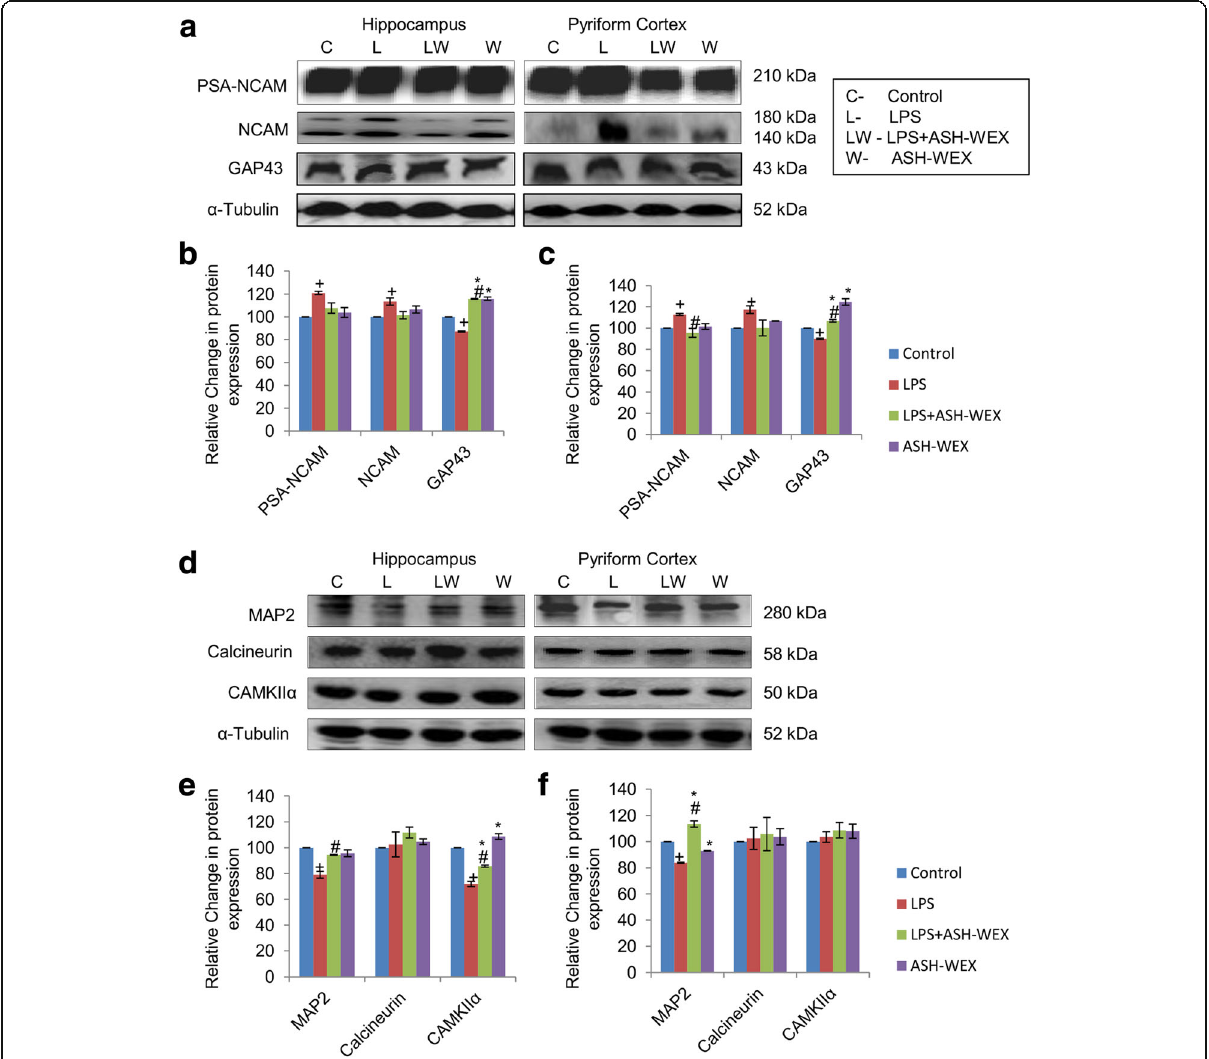
histograms depicting relative densitometric analysis amidst the different treatment groups from ( b ) hippocampus and ( c ) pyriform cortex regions of brain plotted as Mean ± SEM (taking control group as 100%). (Expression of NCAM was calculated as cumulative of both 180 kDa and 140 kDa bands) ( d ) Representative immunoblots of MAP2, Calcineurin and CAMKII α in hippocampus (left panel) and pyriform cortex (right panel) regions treatment groups in ( e ) hippocampus and ( f ) pyriform cortex regions plotted as Mean ± SEM (taking control group as 100%). α -Tubulin was